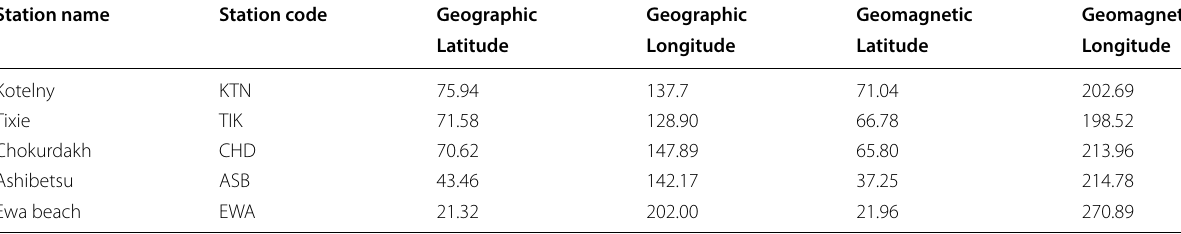
Geomagnetic latitude and longitude at 100 km above the observatories are defined by altitude-adjusted corrected geomagnetic (AACGM) coordinates (Baker and Wing 1989)